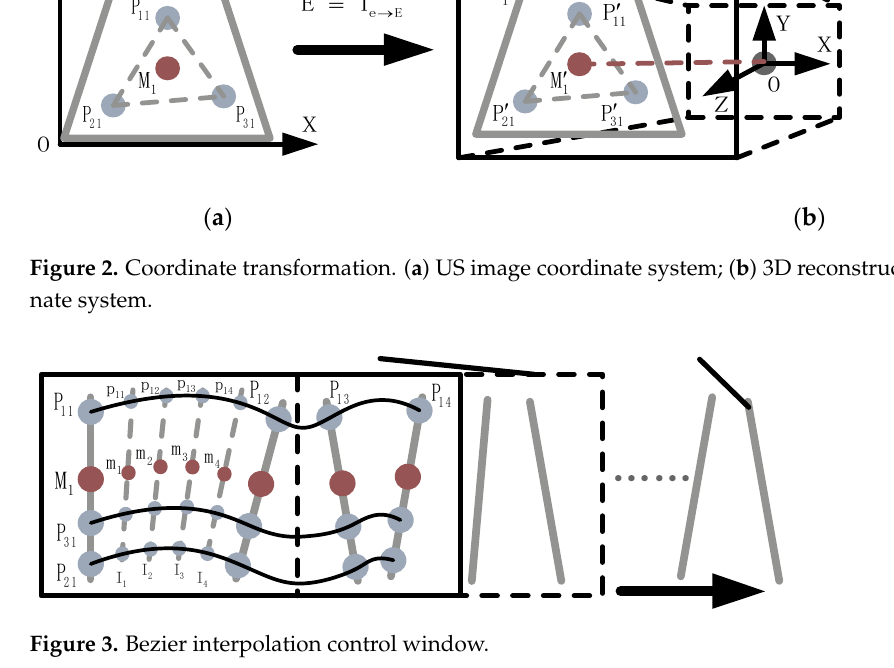
Algorithm 1: Bezier Interpolation of SPRAO STEP1: An ultrasonic probe with an acousto-optic positioning device is used to move and scan the target in one direction at a speed of 1 cm/s. In this process, the probe out- puts 12 FPS B-scans, while the acousto-optic positioning device can output 60 spatial po- sition coordinates and angle information in the reconstructed coordinate system per sec- ond. STEP2: The control window starts to move from the first image frame, four frames at a time, until all B-scans sequences are traversed. Three points of different straight lines are extracted from each frame of image, and three Bezier curves are generated. STEP3: Insert four points between two B-scans on each Bezier curve. Twelve points are inserted into three curves. Calculate the center point coordinates of the plane where the